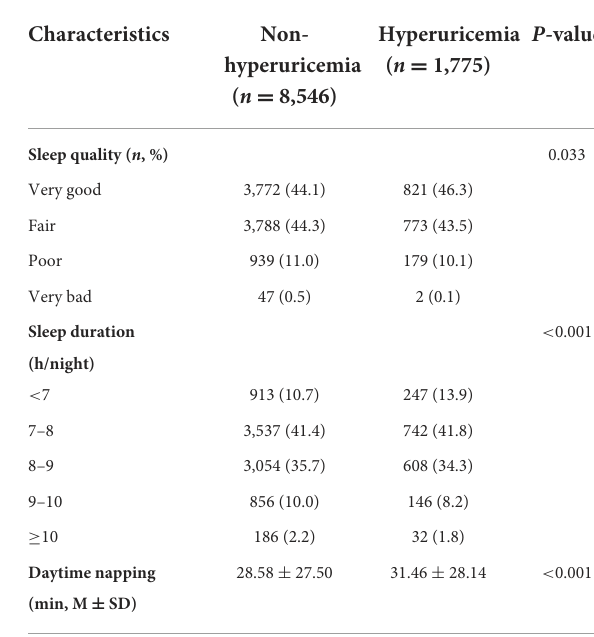
TABLE 1 Characteristics of participants based on